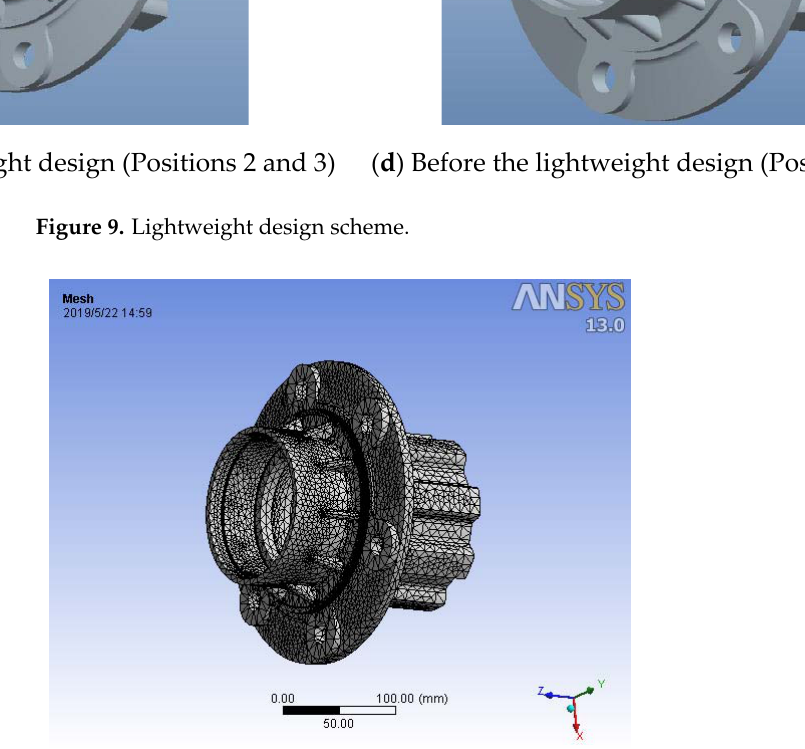
Figure 10. Meshing of the wheel hub after the lightweight